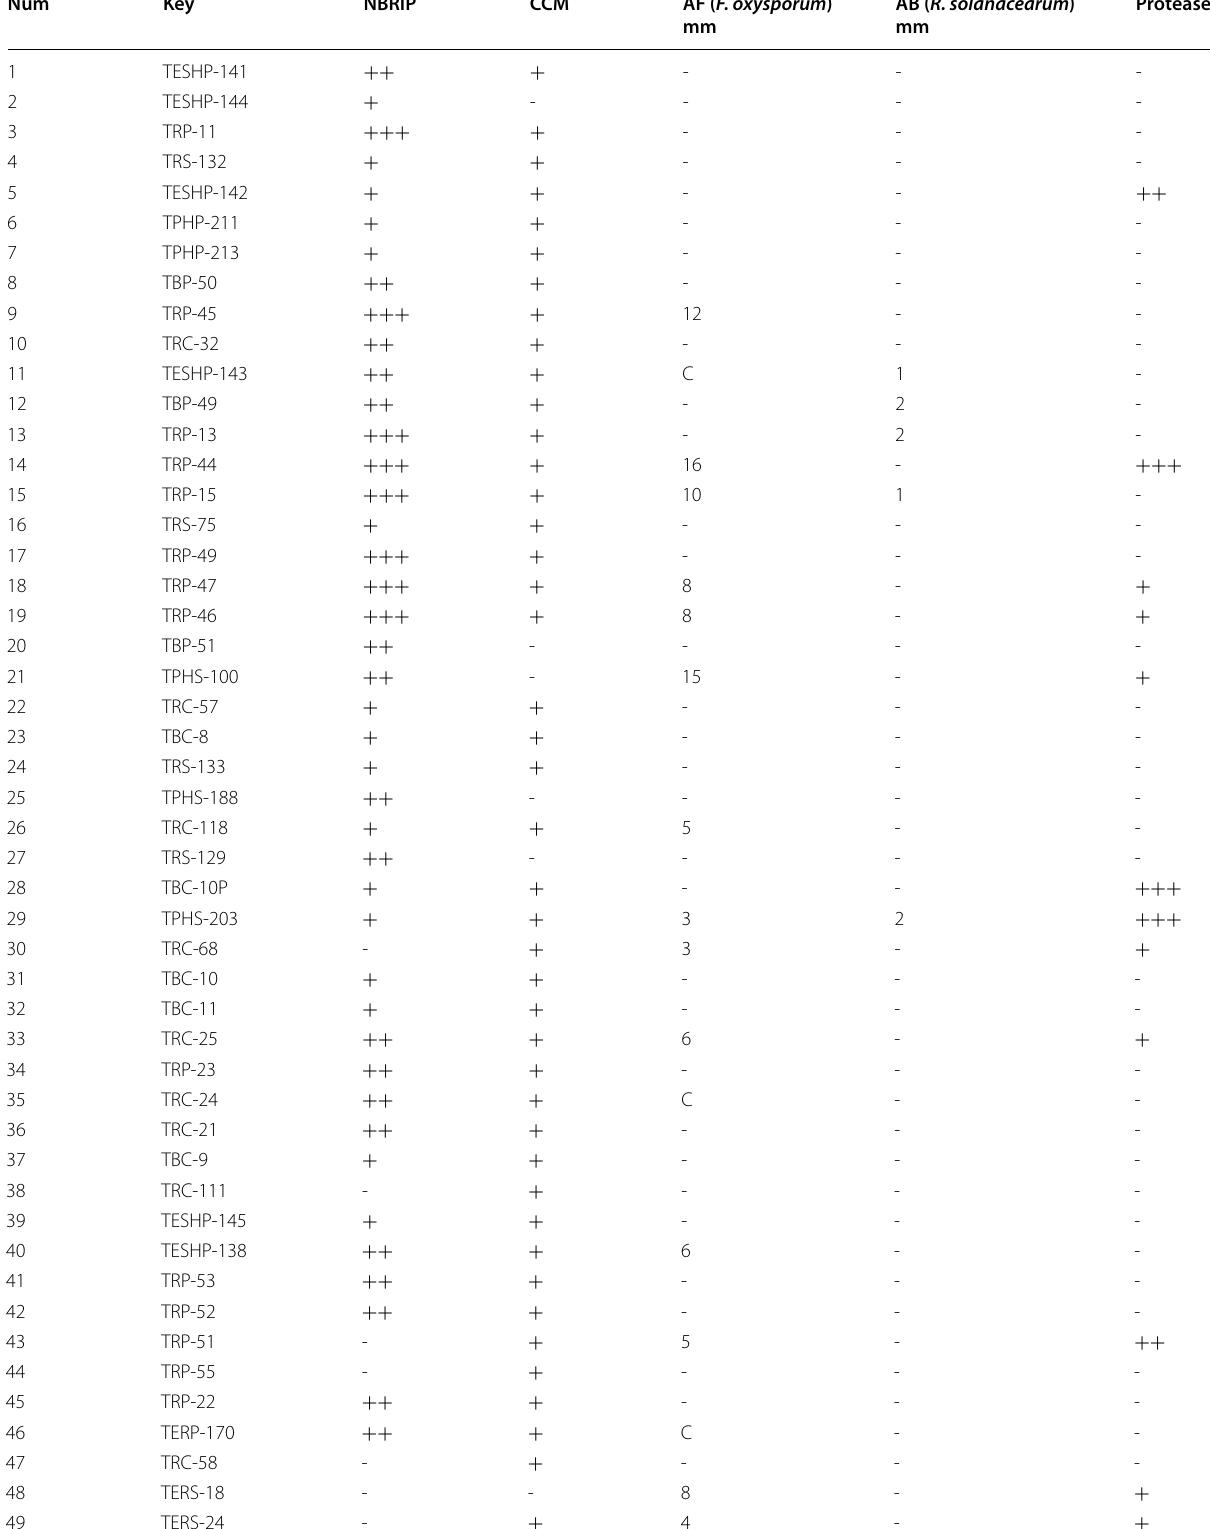
Table 4 Bacterial isolates and in vitro plant growth promoting related functions